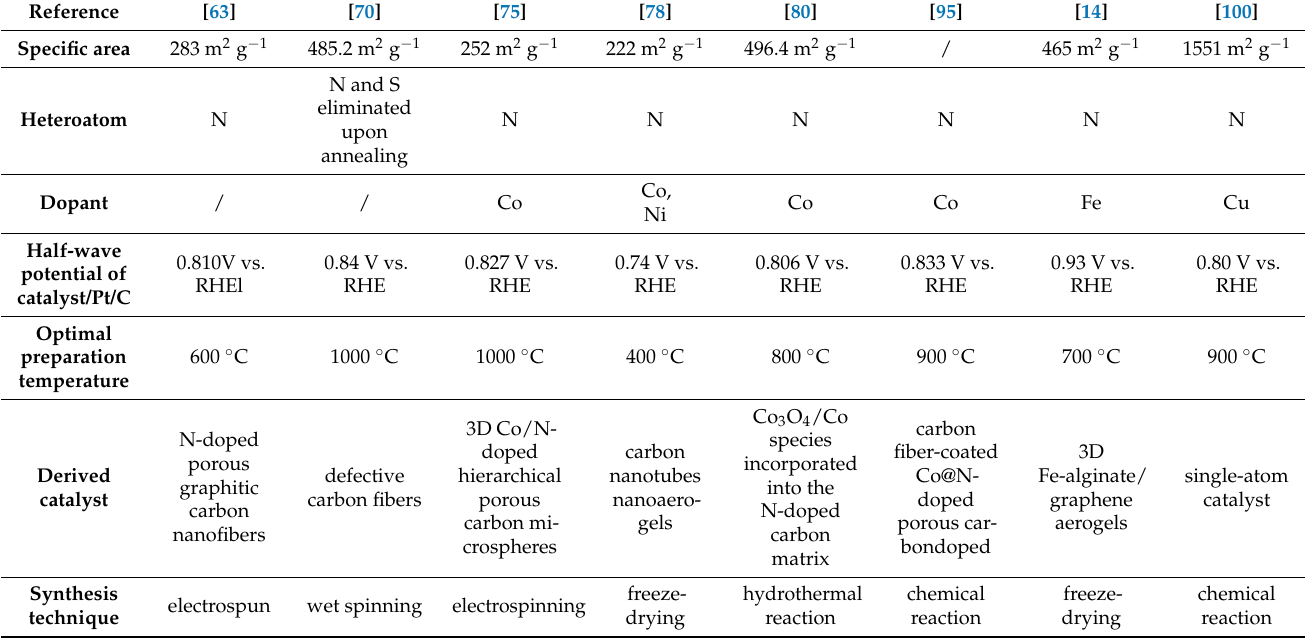
Table 3. ORR catalysts derived from alginate; characteristics, methods for obtention, and type of carbon